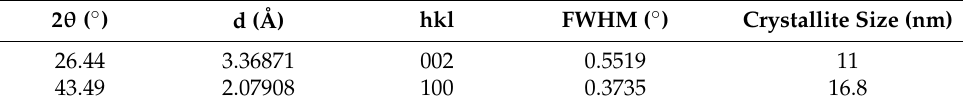
Figure 1. ( a ) XRD pattern of graphene and ( b ) Raman spectrum of the graphene coating. Table 3. Results of XRD analysis of graphene-coated stainless steel. Table 3. Results of XRD analysis of graphene-coated stainless steel.